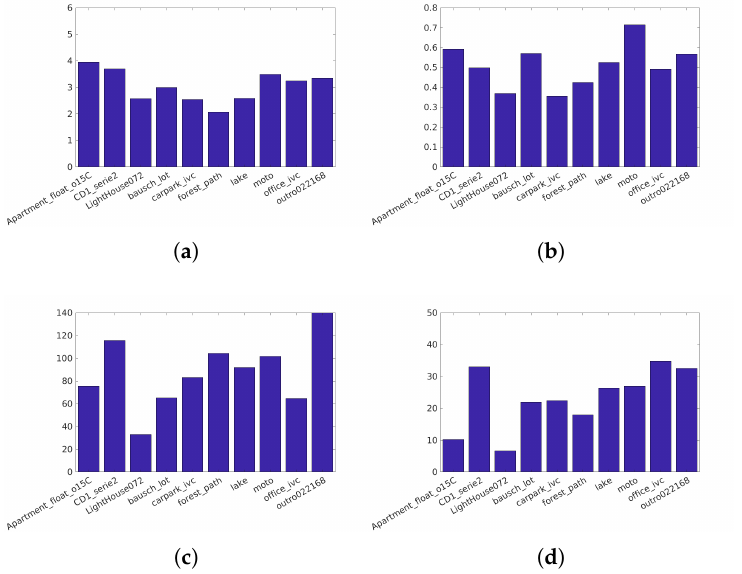
Figure 3. Characteristics of the Narwaria et al. [34] images: ( a ) The dynamic range, ( b ) key, ( c ) spatial Information, ( d )